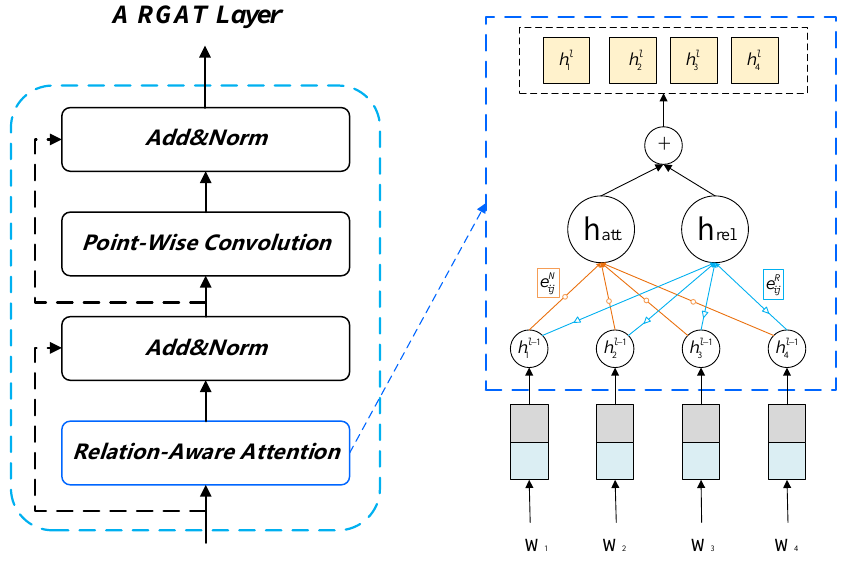
Figure 3. Details of an RGAT layer and its corresponding relation-aware attention